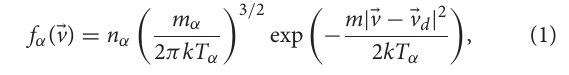
TABLE 1 | Parameters used to define the spatial and temporal ranges for sampling ionospheric densities and temperatures using the IRI model. Parameter Domain Step-size and